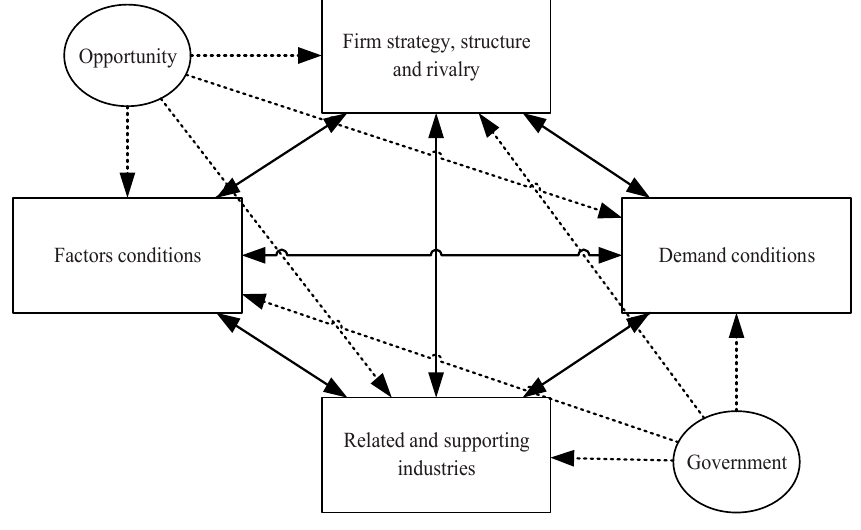
Figure 2. Porter Diamond Model (source: Porter, M. E. [52]).